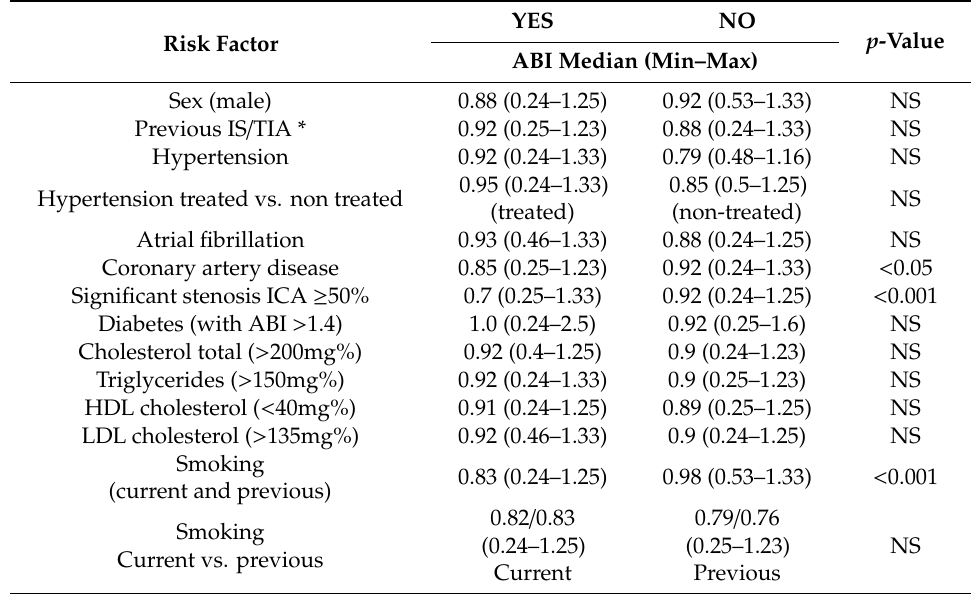
Table 6. ABI values depending on the presence of risk factors in the stroke